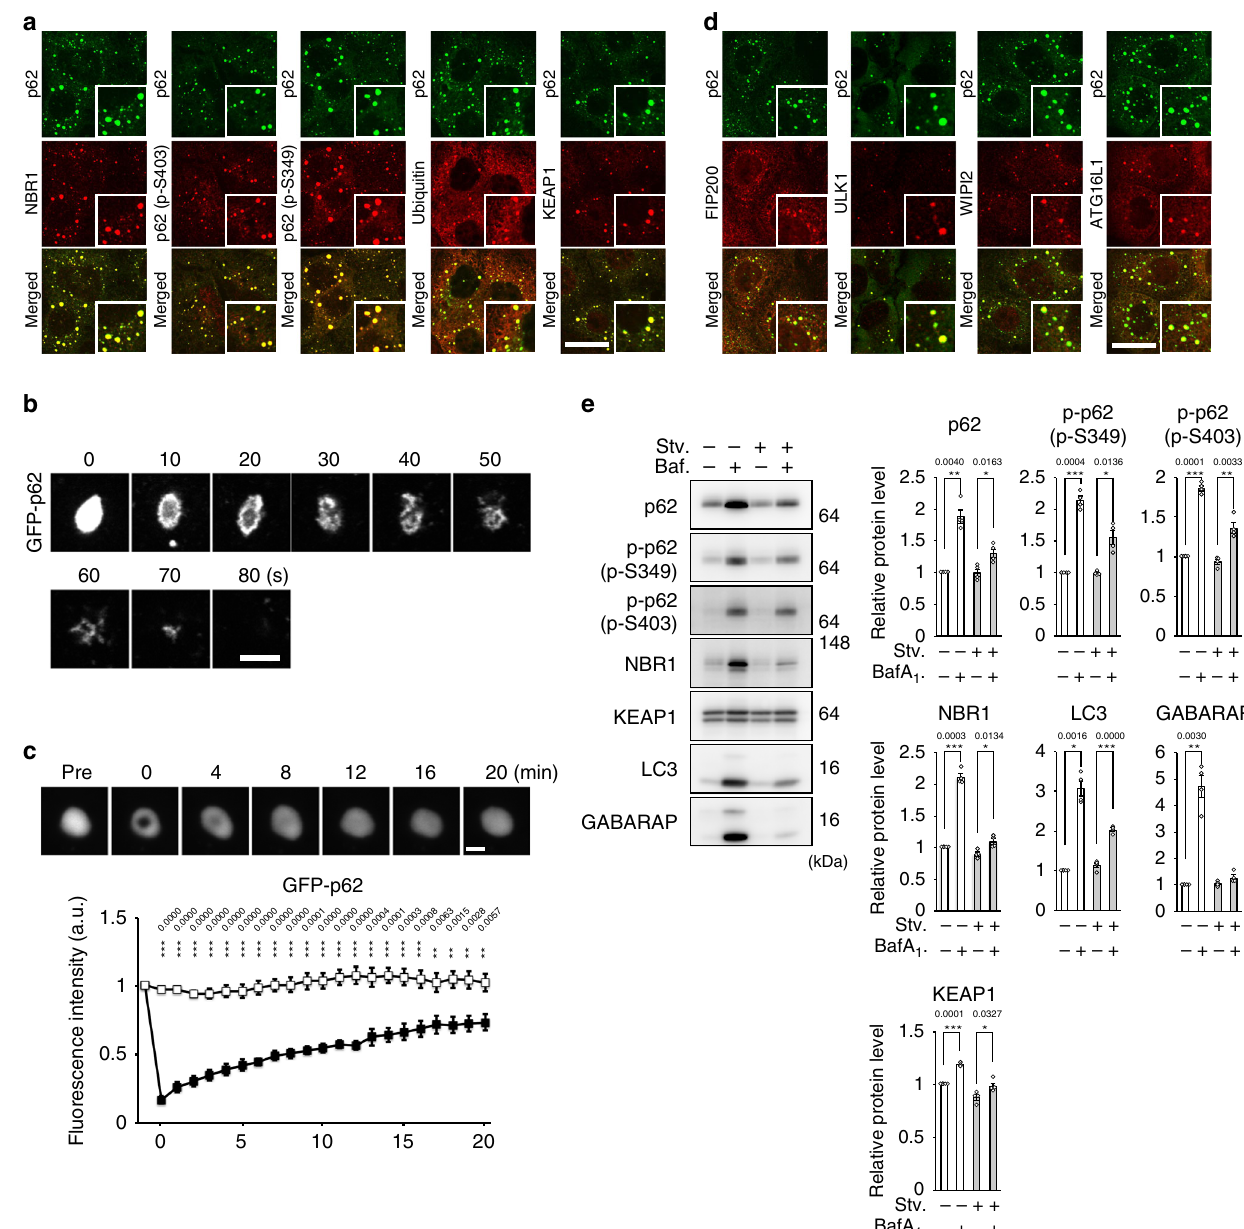
Fig. 1 p62-gels are degraded by autophagy. a Immuno fl uorescence microscopy. Huh-1 cells were immunostained with indicated antibodies. Bars: 10 μ m. b Time lapse microscopic analysis. Huh-1 cells were transfected with GFP-p62. 24 h after the transfection, the p62-bodies labelled GFP-p62 were isolated from the cells and treated with 1,6-hexanediol. Bar: 5 μ m. c Time lapse microscopic analysis. Huh-1 cells were infected by GFP-p62. 24 h after the infection, the p62-bodies labelled by GFP-p62 were photobleached, and then time of fl uorescent recovery was measured. Data are means ± s.e of nonphotobleached ( n = 7) and photobleached ( n = 10) dots. ** p < 0.01, and *** p < 0.001 as determined by two-sided Welch ’ s t -test. Bar: 2 μ m. Source data are provided as a Source Data fi le. d Immuno fl uorescence microscopy. Huh-1 cells were immunostained with indicated antibodies. Bar: 10 μ m. e Immunoblot analysis. Huh-1 cells were cultured in regular medium in the presence or absence of 100 nM Ba fi lomycin A 1 (Baf.) for 24 h or cultured in amino acid-deprived medium (Stv.) for 4 h in presence or absence of Baf. Cell lysates were prepared and subjected to immunoblot analysis with the indicated antibodies. Data shown are representative of four separate experiments. Bar graphs indicate the quantitative densitometric analysis of the indicated proteins relative to whole proteins estimated by Ponceau-S staining ( n = 4). Data are means ± s.e. * p < 0.05, ** p < 0.01, and *** p < 0.001 as determined by two-sided Welch ’ s t -test. Source data are provided as a Source Data fi